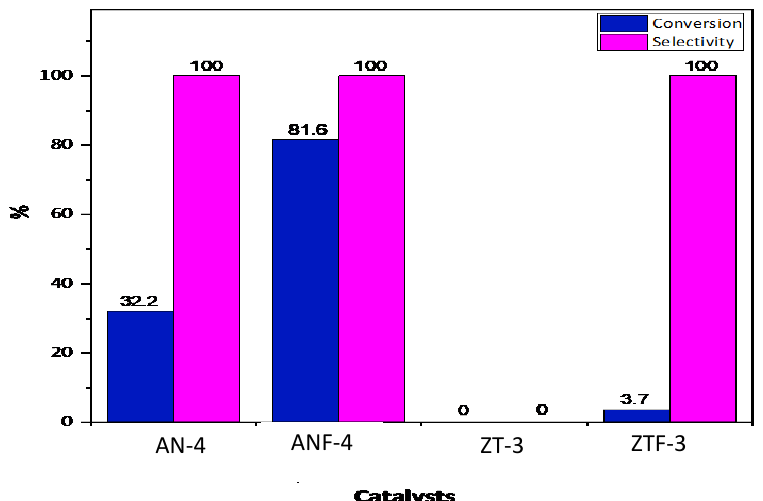
Figure 10. Conversion of 3,4-dimethoxy benzaldehyde by catalysts to form acetal and selectivity to 2-(3,4-dimethoxy-phenyl)-4-methyl-1,3-dioxolane.